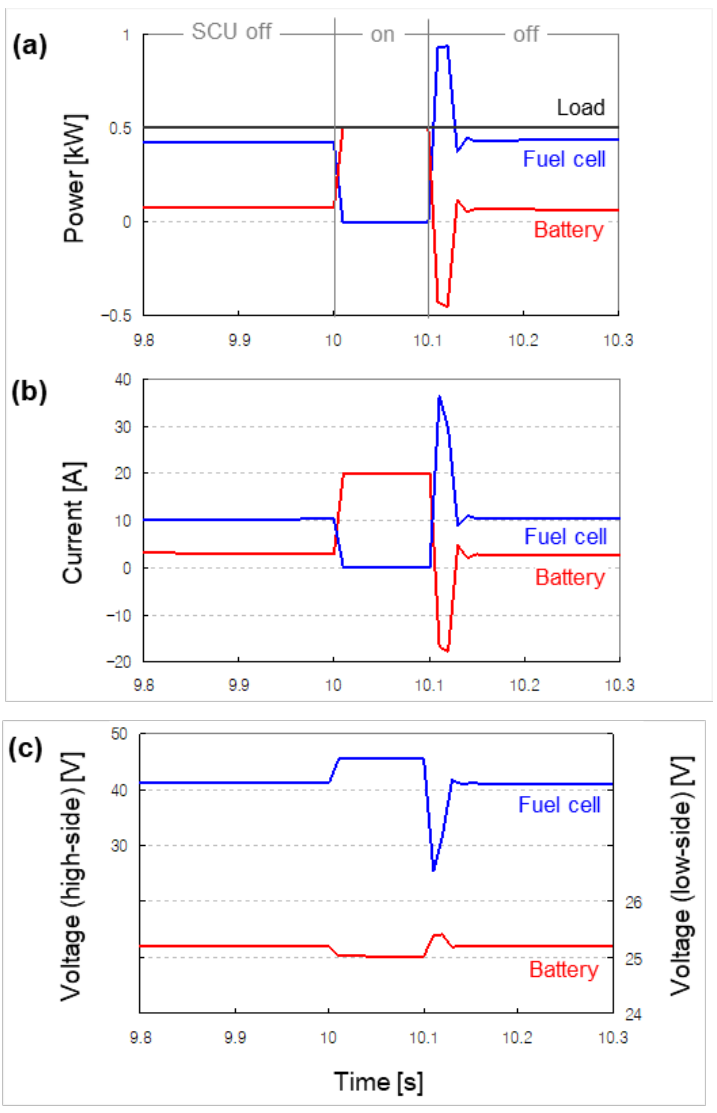
Figure 11. Simulated ( a ) power, ( b ) current, and ( c ) voltage of HPS under the short-circuit condi- tion.